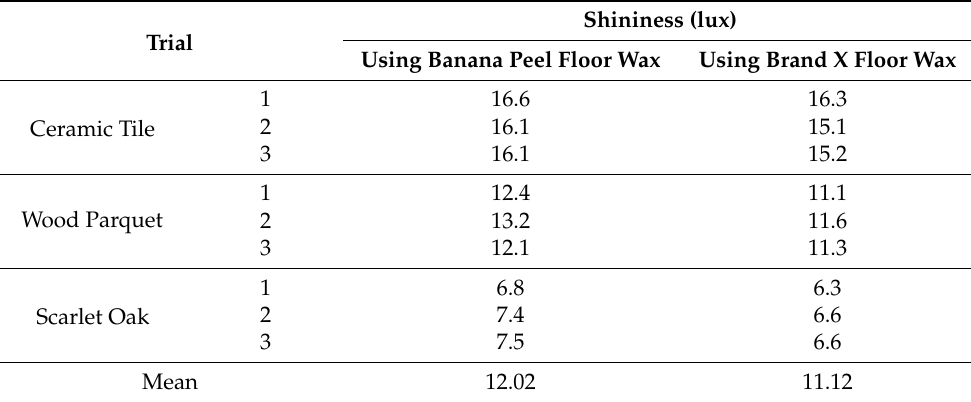
Table 28. Shininess using wide light range meter [33].